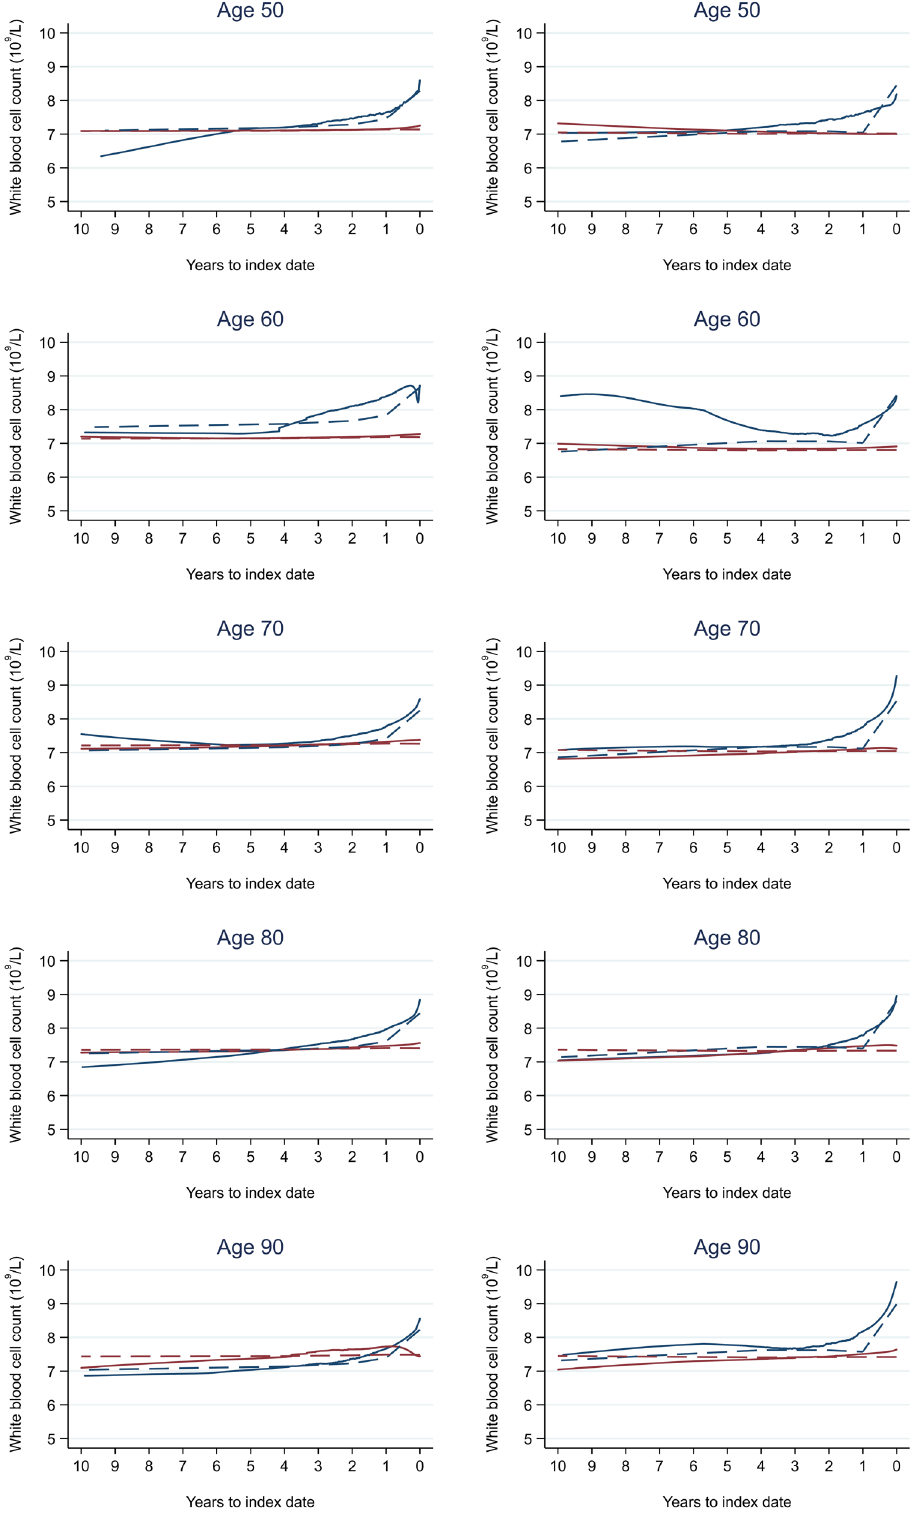
Figure 12. White blood cell count trends between cases and controls, by age at index date 1,2 . 1 Index date was the date of diagnosis for cases and a randomly selected date in the patient’s study period for controls. 2 LOWESS trends are age (+/- 3 years) and modelled (fixed effects) trends are taken at that specific age. Legend: males (left) and females (right). Colorectal cancer (blue line) and no cancer (red line). LOWESS trend (solid line) and modelled trend (dashed